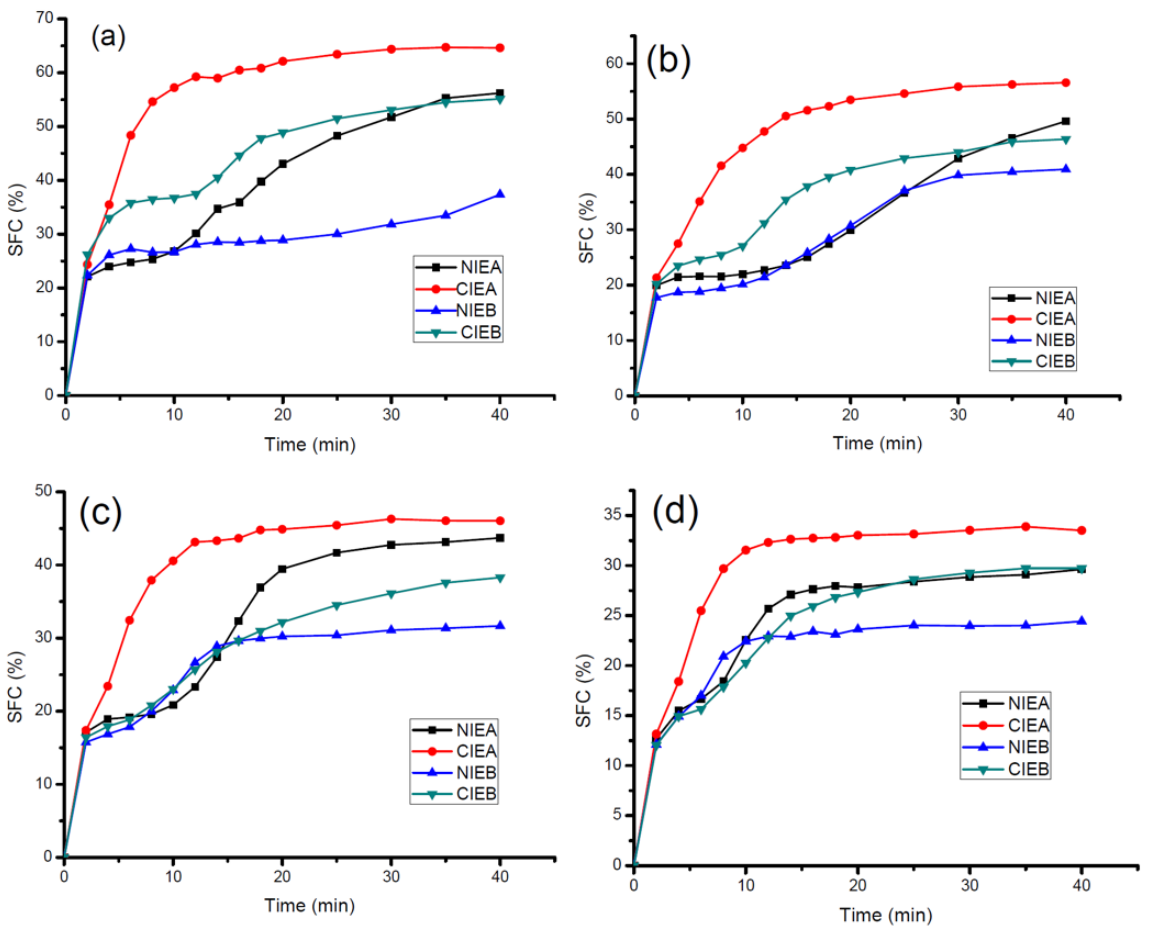
Figure 4. Isothermal Crystallization rate of sheet margarine at 5 °C ( a ), 10 °C ( b ), 15 °C ( c ), and 20 °C ( d ).